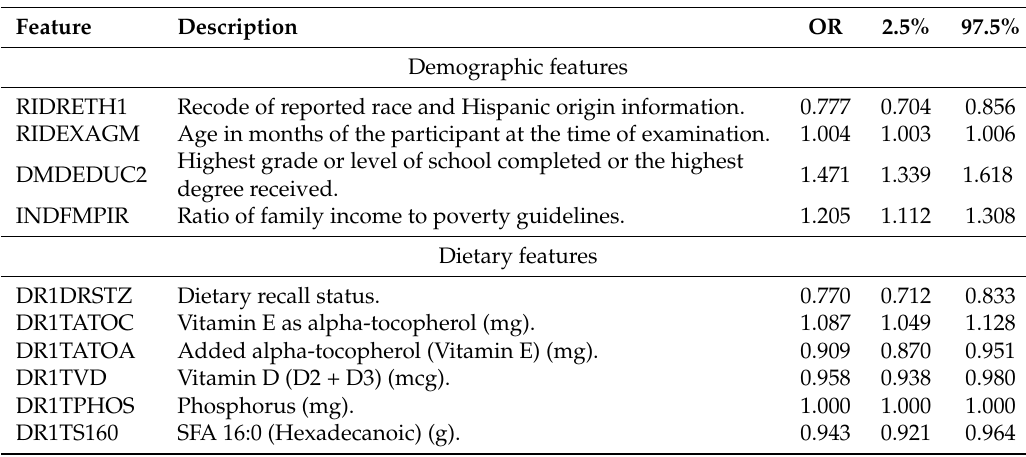
Table 6. OR values and confidence intervals (2.5%/97.5%) obtained by the statistical analysis of the multivariate model corresponding to age group 4, containing four demographic features and six dietary